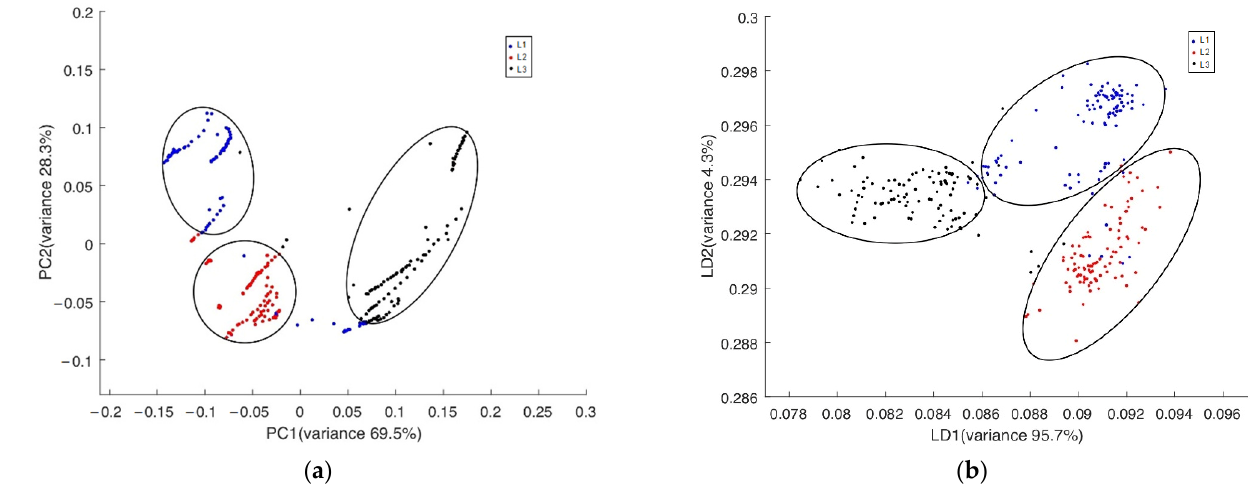
Table 4. The features and component contribution rate.